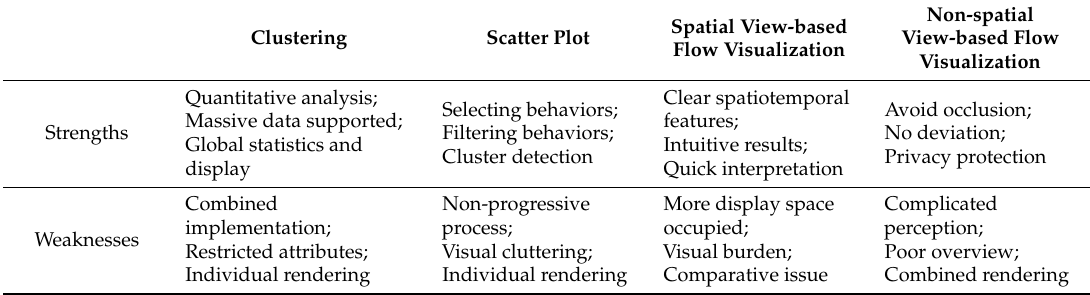
Table 4. Overview comparing strengths and weaknesses of multidimensional visualization